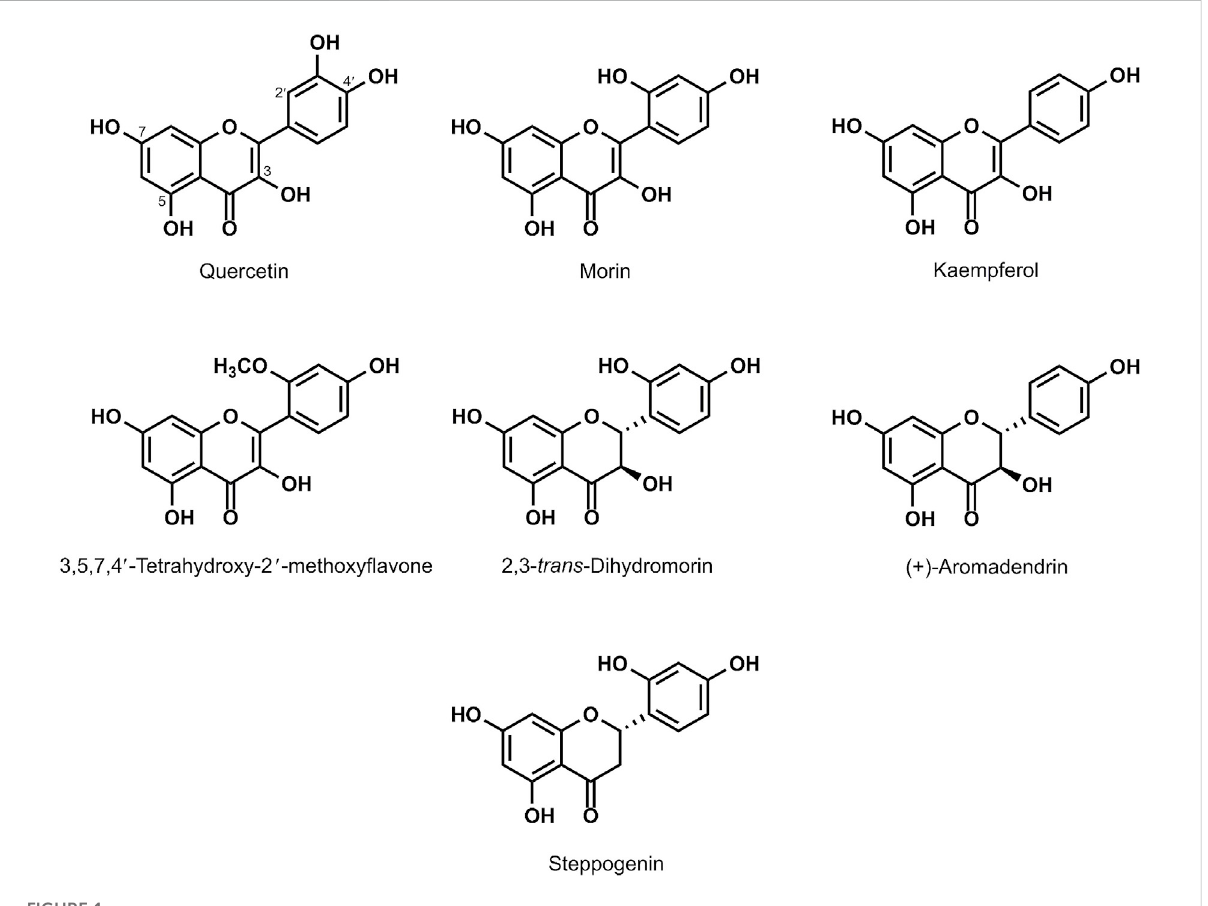
FIGURE 1 Structures of quercetin and analogues used in this